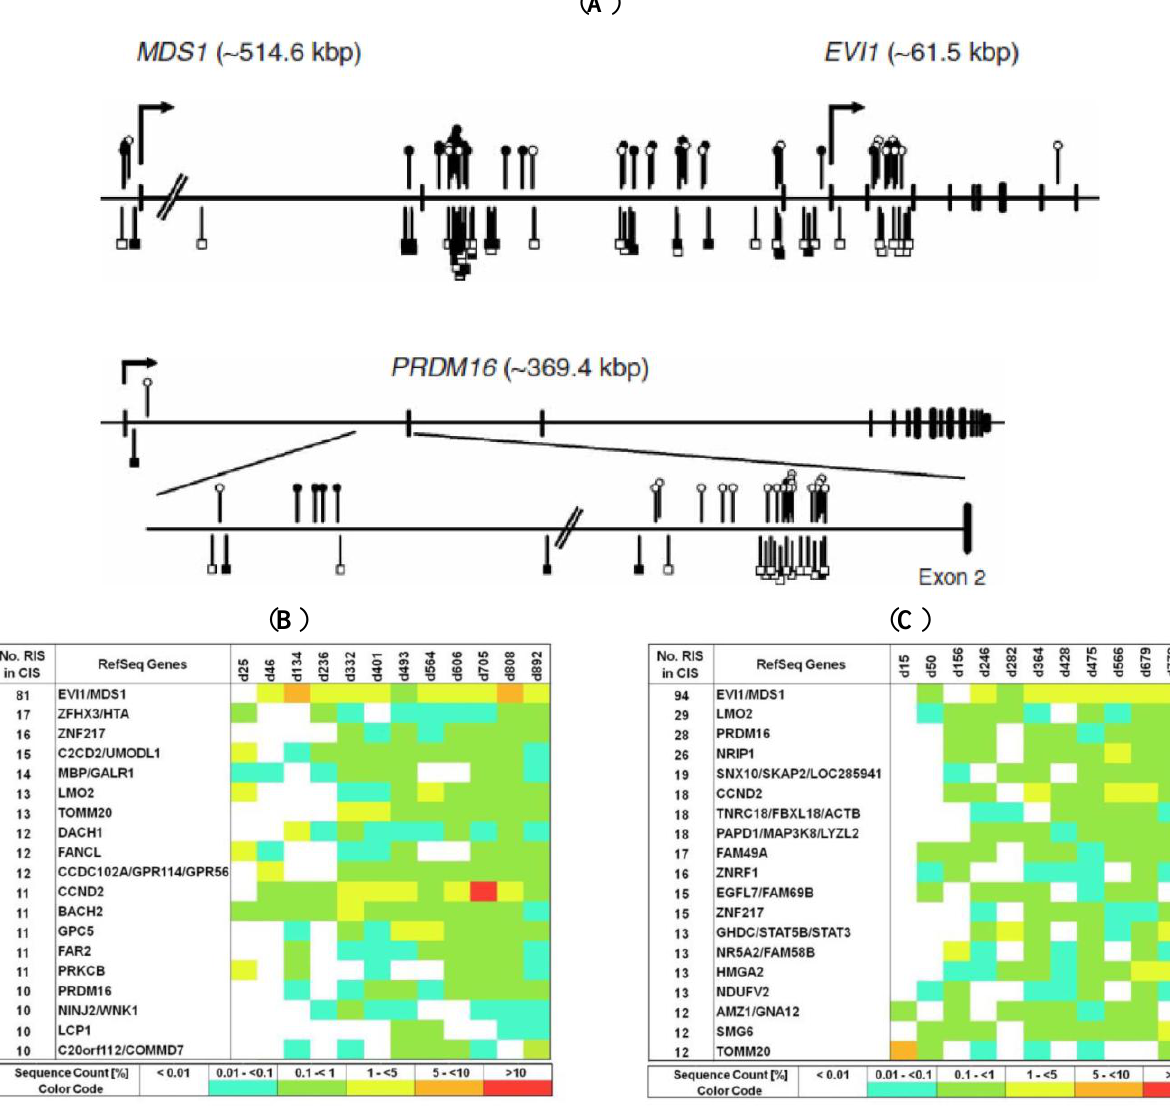
Figure 4. Retroviral integration into common insertion sites in clinical gene therapy trials. ( A ) Clustering of retroviral integration sites (RIS) within clones sharing integrations in MDS1-EVI1, PRDM16 and SETBP1 in the X-CGD clinical trial identified by linear amplification-mediated PCR (LAM-PCR) (modified from Ott et al. [113]). ( B ) Clinical monitoring of retroviral gene corrected hematopoietic stem/progenitor cells (HSC) by LAM-PCR and 454 sequencing in two patients from the WAS gene therapy trial over